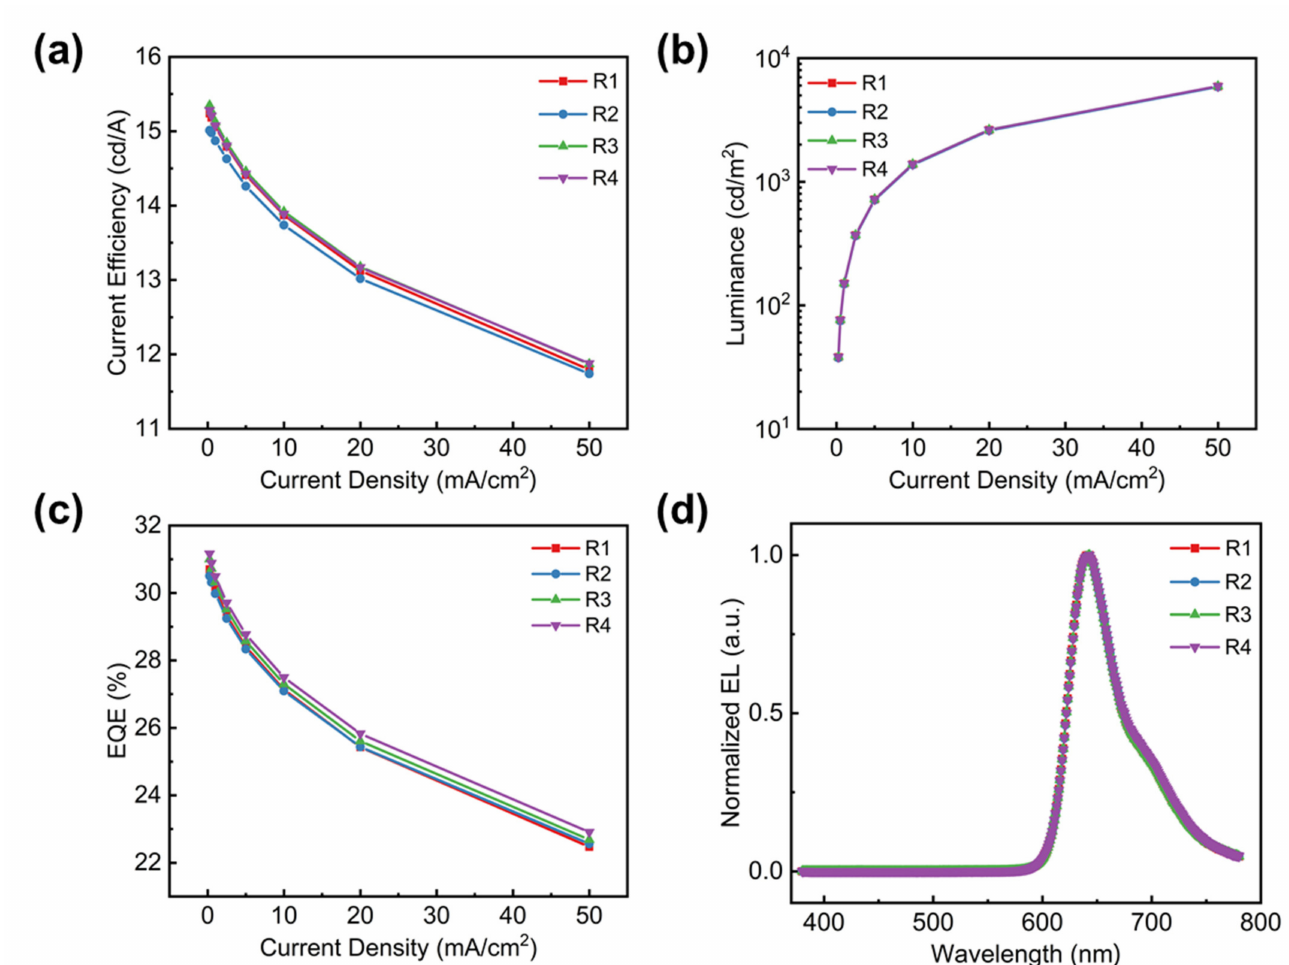
Figure 3. Device performance of devices R1–R4. ( a ) Current efficiency–current density, ( b ) luminance– current density, ( c ) external quantum efficiency–current density, and ( d ) EL spectra under a current density of 1 mA/cm 2